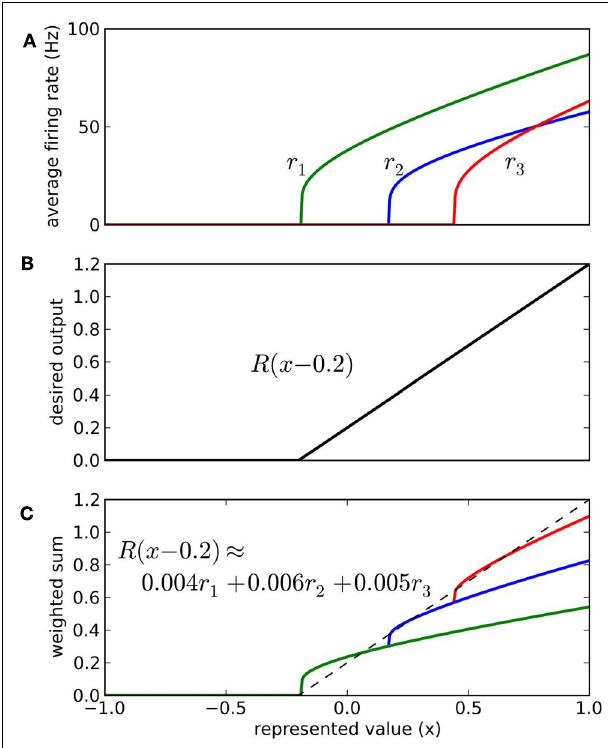
FIGURE 3 |Approximating a desired function by weighted sums of tuning curves. The three neurons in (A) fire at different rates when representing different x values.To approximate the desired function shown in (B) , we weight each tuning curve r i by a different value d i and add them together (C) .These weighting factors d i can be calculated with Eq. 9 and used to find synaptic connection weights with Eq.